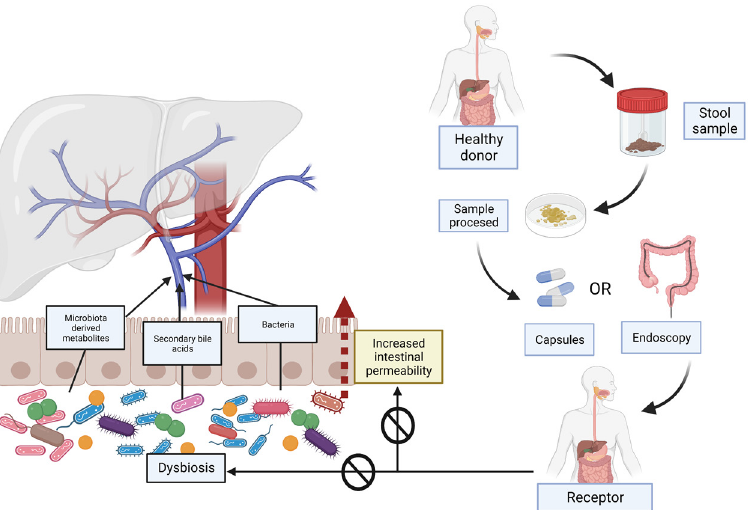
Figure 2. Non-alcoholic-fatty-liver-disease (NAFLD)-related dysbiosis and increased intestinal permeability and the utility of faecal microbiota transplantation (FMT). The increase in intestinal permeability enables bacteria and their metabolites to reach the liver through the portal system. In FMT, a stool sample is taken from a healthy donor. After processing, it will be administered to the receptor subject with NAFLD. The FMT can be performed in different ways, either orally or by endoscopy or enemas. FMT is intended to reverse existing dysbiosis and restore the intestinal barrier, and consequently improve the severity of the disease.